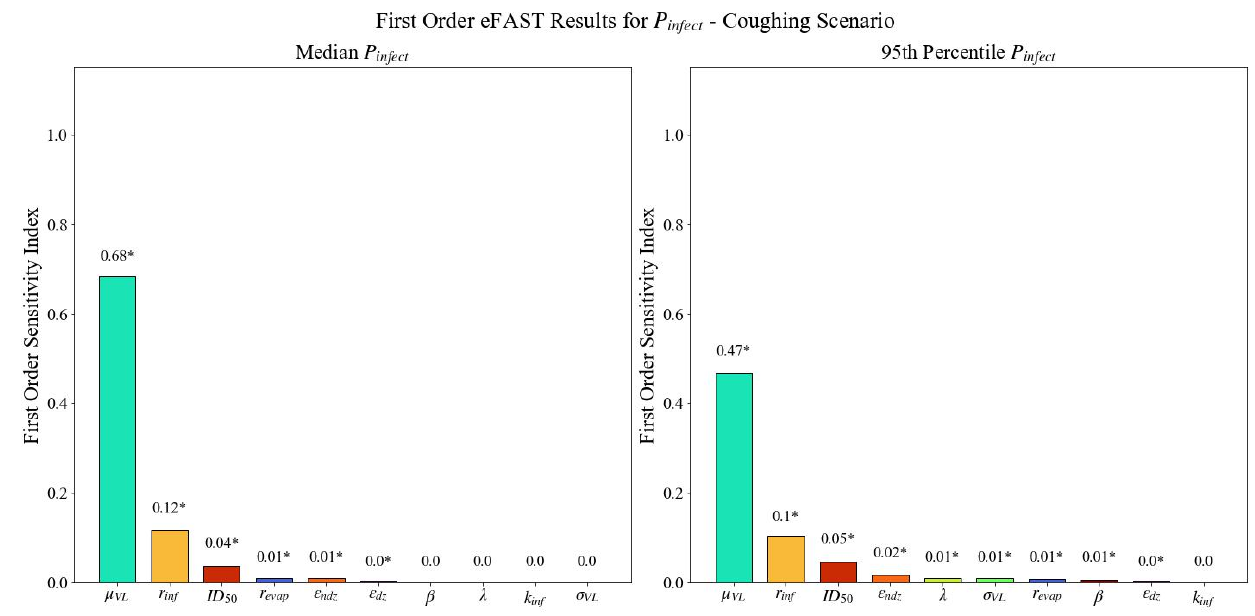
Figure A6. First-order sensitivity indices (ordered from largest to smallest) derived using eFAST for the median 𝑃 𝑖𝑛𝑓𝑒𝑐𝑡 and 95th percentile of 𝑃 𝑖𝑛𝑓𝑒𝑐𝑡 with breathing as the emission mechanism. Asterisks (*) indicate statistically significant sensitivity indices ( α = 0 .01).